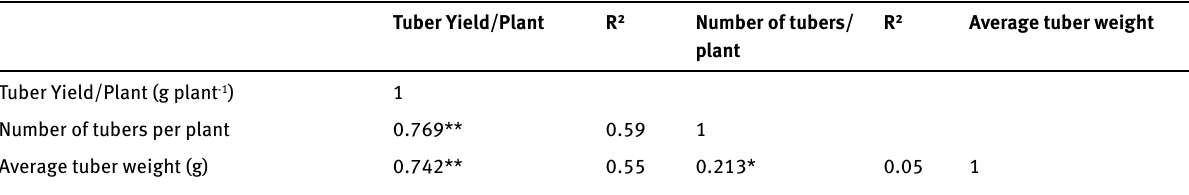
Table 7: Pearson correlations between tuber yield and its components in 64 full-sib families evaluated under warm environments. 2014-2015